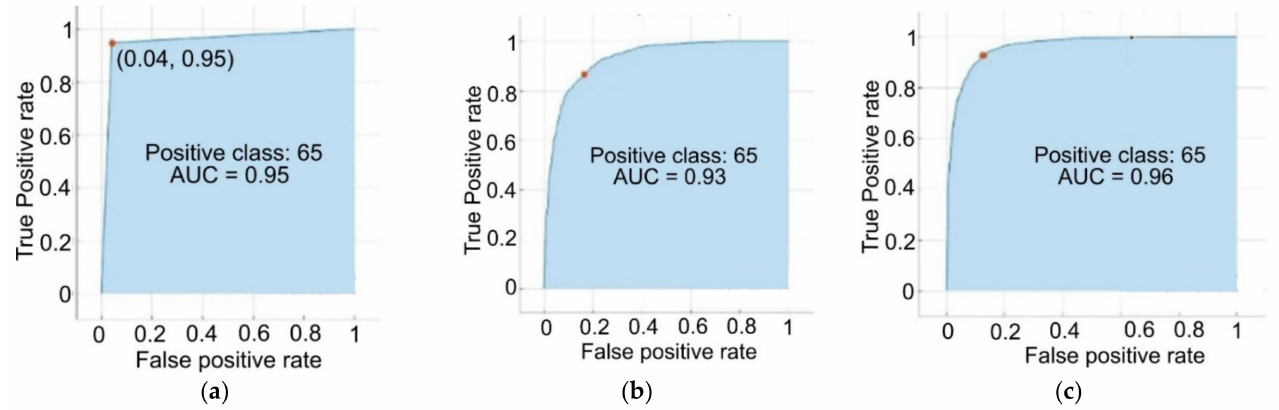
Figure 7. ROC on ten-fold cross-validation. ( a ) Fine KNN; ( b ) WNN; ( c )